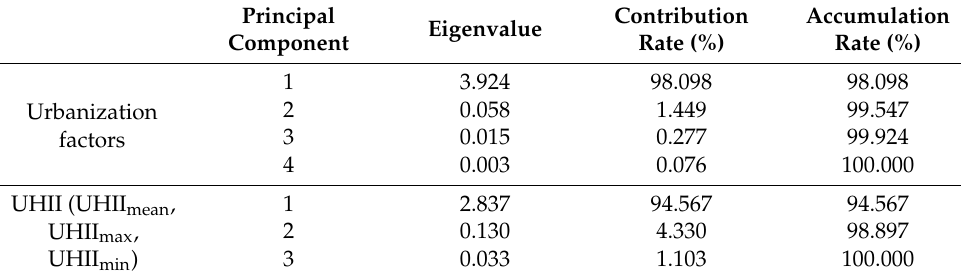
Table 7. Index characteristic values and contribution rates.